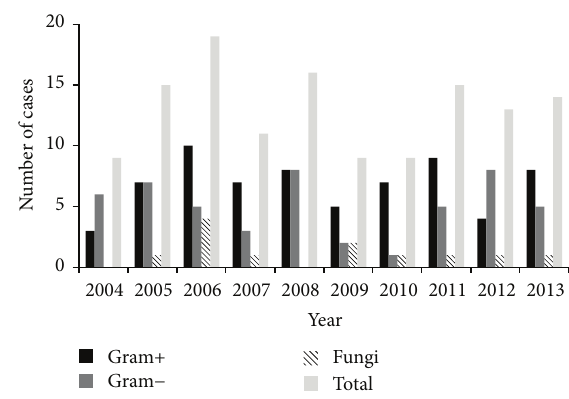
Figure 1: Distribution of Gram-positive, Gram-negative bacteria, and fungus over 10